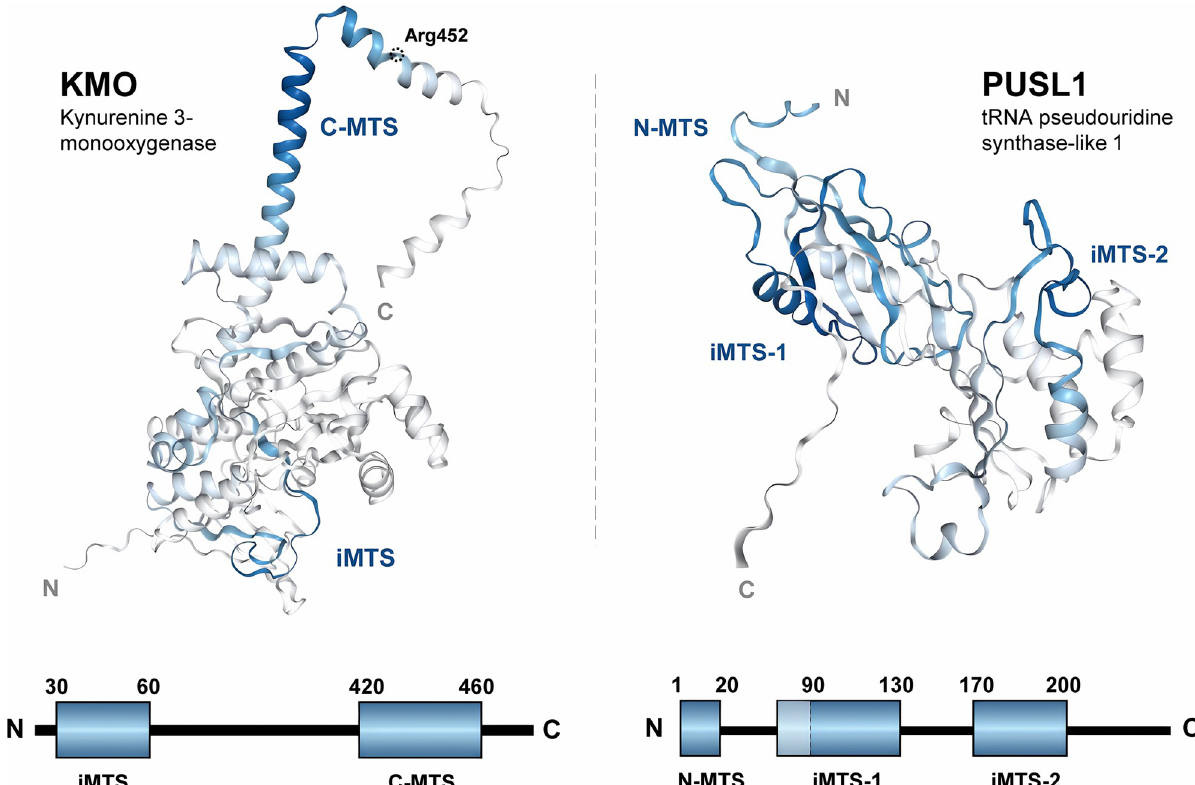
Fig 4. Structural visualization of human KMO and PUSL1 iMTS propensity via MTSviewer. AlphaFold models of KMO (Uniprot: O15229) and PUSL1 (Uniprot: Q8N0Z8) colored by iMLP score within MTSviewer. MTS’s are annotated as blue rectangles on the sequence schematics. The C-MTS of KMO is predicted as helical, solvent-accessible, and is distinct from the folded domain of KMO. Arg452 is highlighted as a variant of interest ( Arg452Cys ). PUSL1 contains a putative N-MTS and two iMTS’s (denoted iMTS-1 and iMTS-2), which are both found within the folded domain and would likely be inaccessible for TOM70 binding in this mature